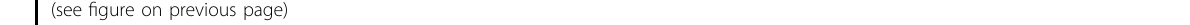
Fig. 4 Effect of luteolin on ischemic rats ’ brains. a Compared with the DMSO group, the neurologic de fi cit scores were signi fi cantly decreased in the luteolin-M group and luteolin-H group at 24 and 72 h, but no signi fi cant differences were found in the luteolin-L group. * P < 0.05, compared with the same time-point in the DMSO group. b , c Compared with the DMSO group, the infarct volume was signi fi cantly reduced in the luteolin-M group and luteolin-H group at 24 and 72 h, but no signi fi cant differences were found in the luteolin-L group. * P < 0.05, compared with the same time-point in the DMSO group. d The expression levels of MMP9 were suppressed by luteolin in coronal sections around the infarcted area of the brain. * P < 0.05, compared with the same time-point in the DMSO group. e The expression levels of PI3K/Akt signaling pathway-associated proteins were upregulated and activated by luteolin in coronal sections around the infarcted area of the brain. * P < 0.05, compared with the same time-point in the DMSO